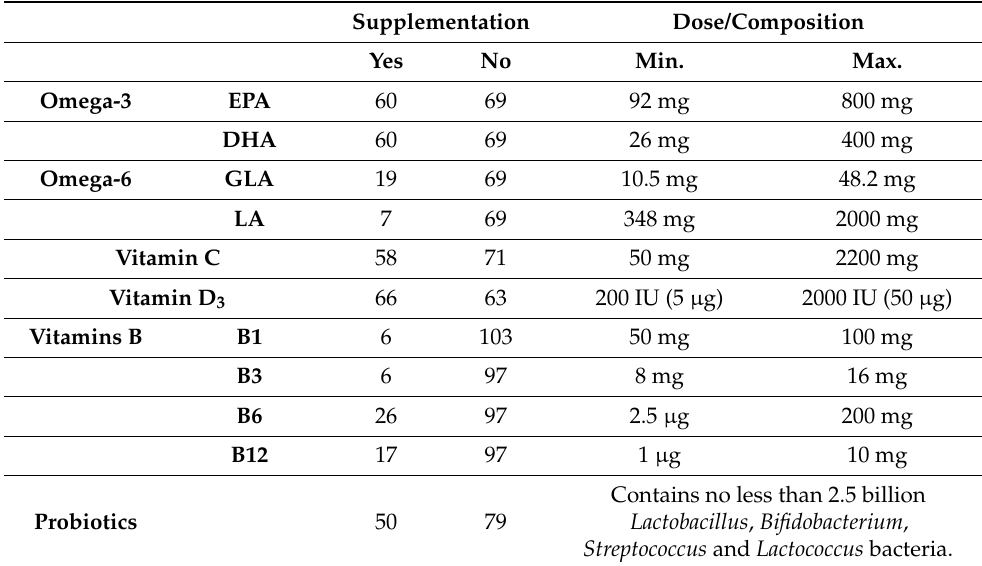
Table 4. Characteristics of studied population regarding